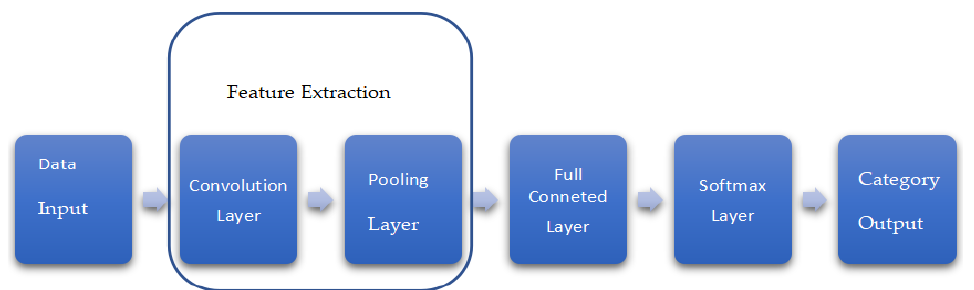
Figure 2. Building blocks of deep convolutional neural network (DCNN) architecture for classifica- tion tion application.